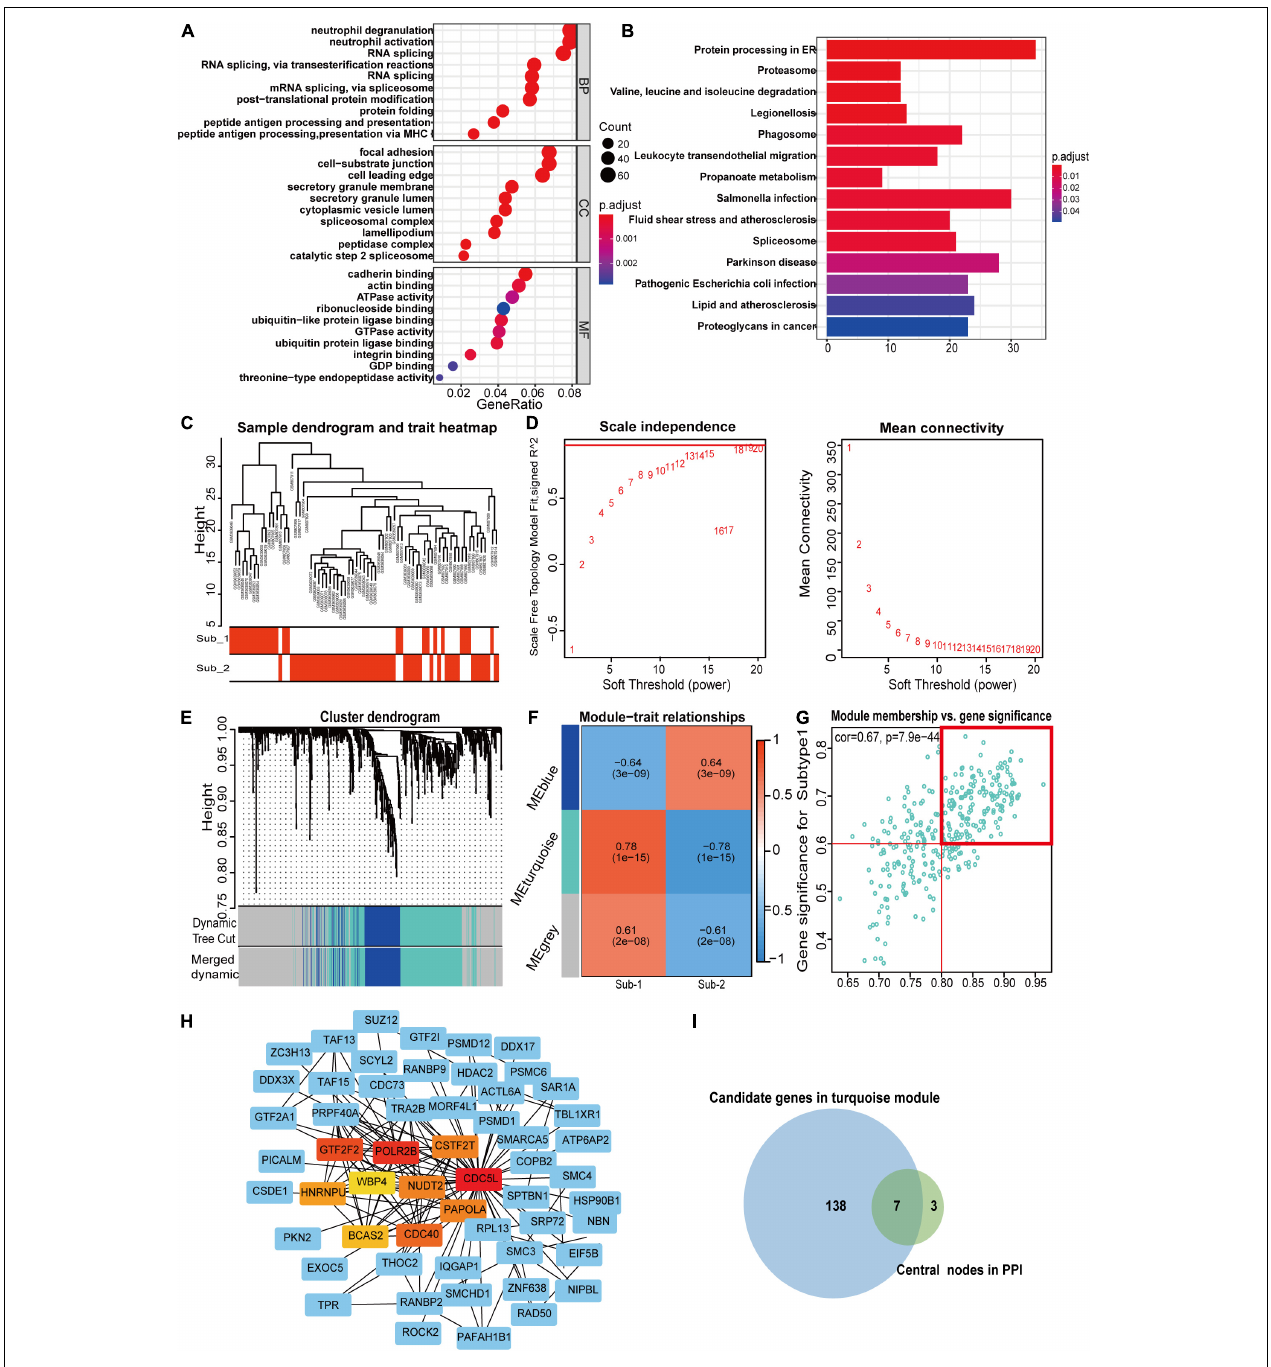
FIGURE 7 | Pathway enrichment analysis of m 6 A regulator related genes (A,B) and identification of m 6 A methylation pattern markers in LN (C–I) . (A) Enrichment analysis of GO biological process, cellular component, and molecular function. (B) Bubble plot of KEGG enrichment pathways. (C) Clustering dendrogram of two m 6 A modification subtypes in LN. (D) Scale-free fitting index analysis and mean connectivity of soft threshold power from 1 to 20. (E) Clustering dendrograms for m 6 A regulator-related genes. According to dynamic tree cutting, the genes were clustered into different modules through hierarchical clustering and merged when the correlation of the modules is > 0.8. Each color represents each module. (F) Correlation heatmap between module eigen genes and m 6 A subtypes. (G) Scatter plot of m 6 A subtype 1 in the turquoise module. In the turquoise module, GS and MM show a very significant correlation, indicating that the genes of the turquoise module are highly related to the m 6 A modification subtype. The dots in the red box indicate that the module membership of these genes is > 0.8, and their gene significance > 0.6, meaning that these dots are the hub genes of the turquoise module. (H) PPI analysis network of m 6 A methylation-related genes from the turquoise module 10, the central nodes in PPI are marked in red, orange, and yellow. (I) Venn diagram of seven m 6 A modification markers. The central nodes of PPI (green set) were overlapped with the hub genes in the turquoise module (blue set) by weighted correlation network analysis.